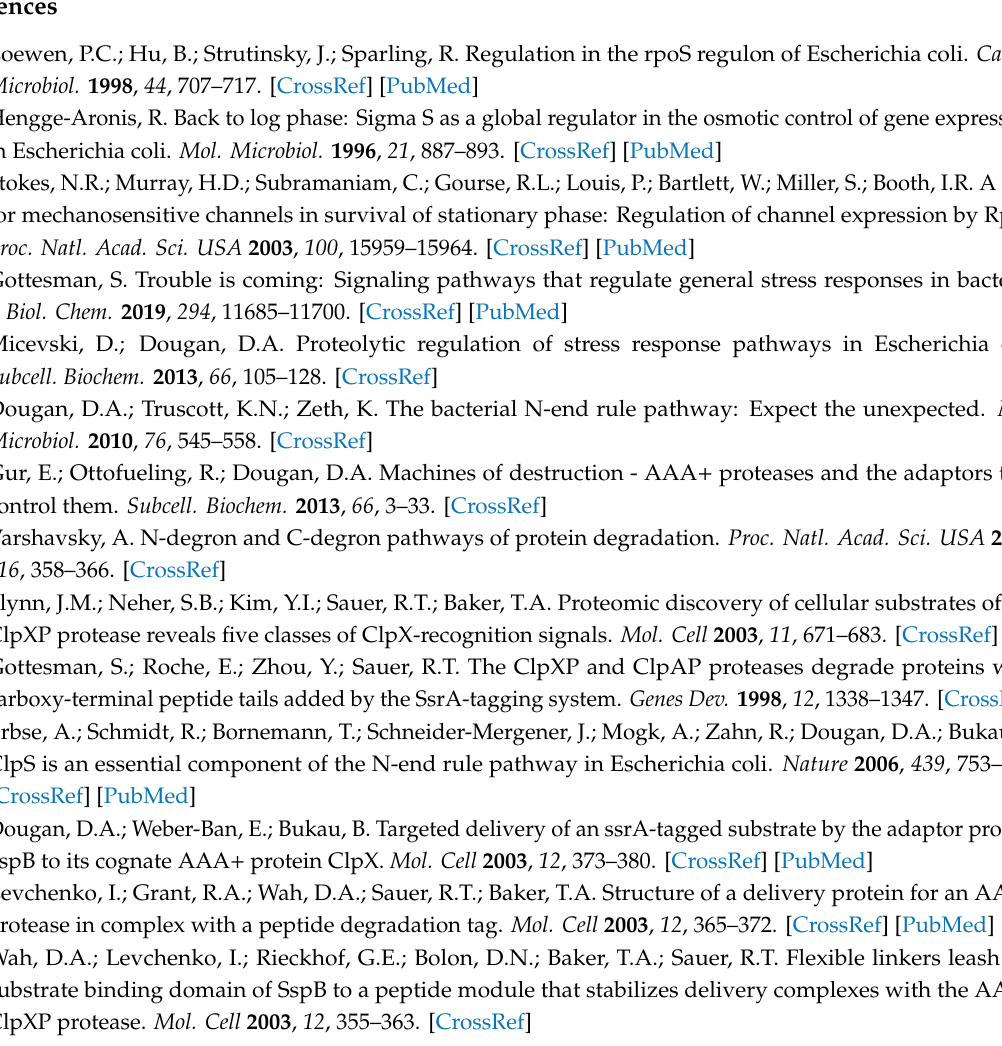
Table S3: RssB Peptide library spot sequences, Table S4: Data collection and refinement statistics of RssB N and RssB C , Table S5: Preliminary SAXS modelling data for σ s , RssB and the RssB / σ s